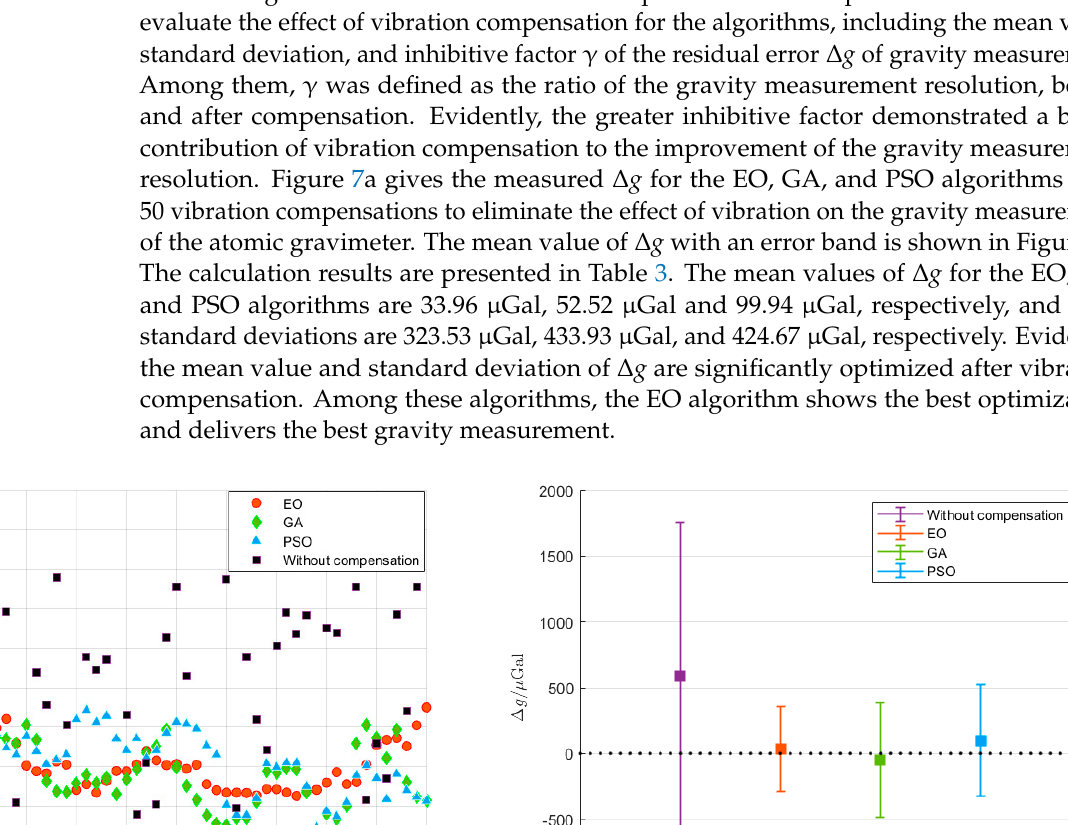
Figure 8. Allan deviation of gravity measurement. Table 3. Comparison of results from 50 vibration compensations. EO PSO Average of